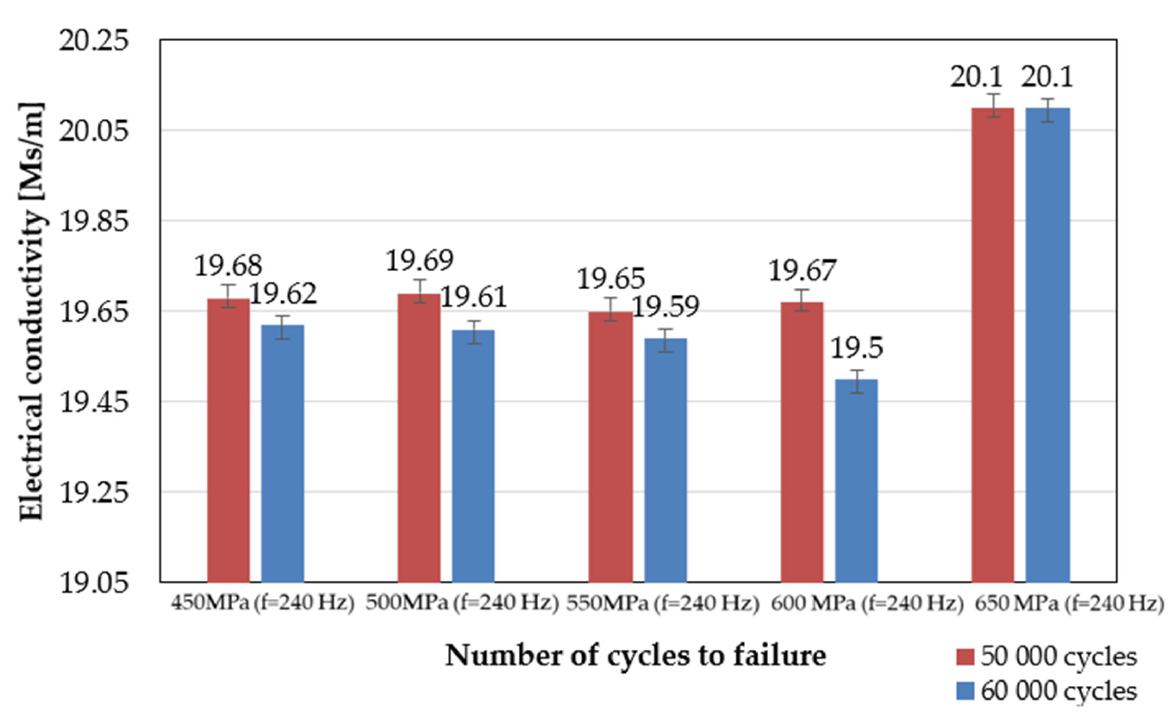
Figure 11. Comparison of electrical conductivity evolution measurements in the selected loading cycles.